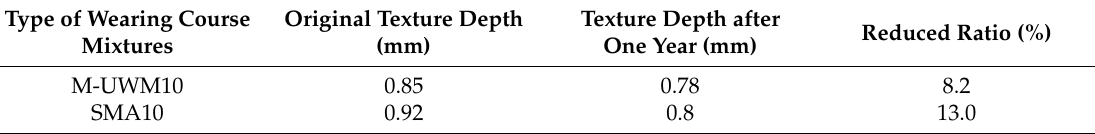
Figure 7. Field texture depth test. Table 4. Field test results of texture depth test on different test roads.